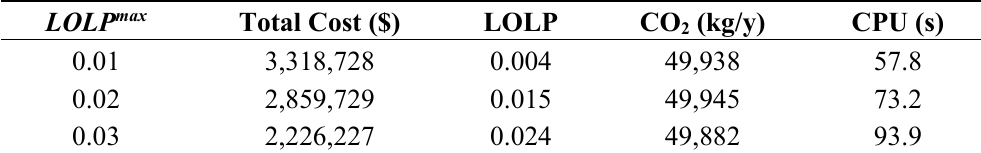
Figure 4. Numbers of WTG, PV, ES, and diesel generators considering different LOLP max . Table 6. Result comparison between different LOLP